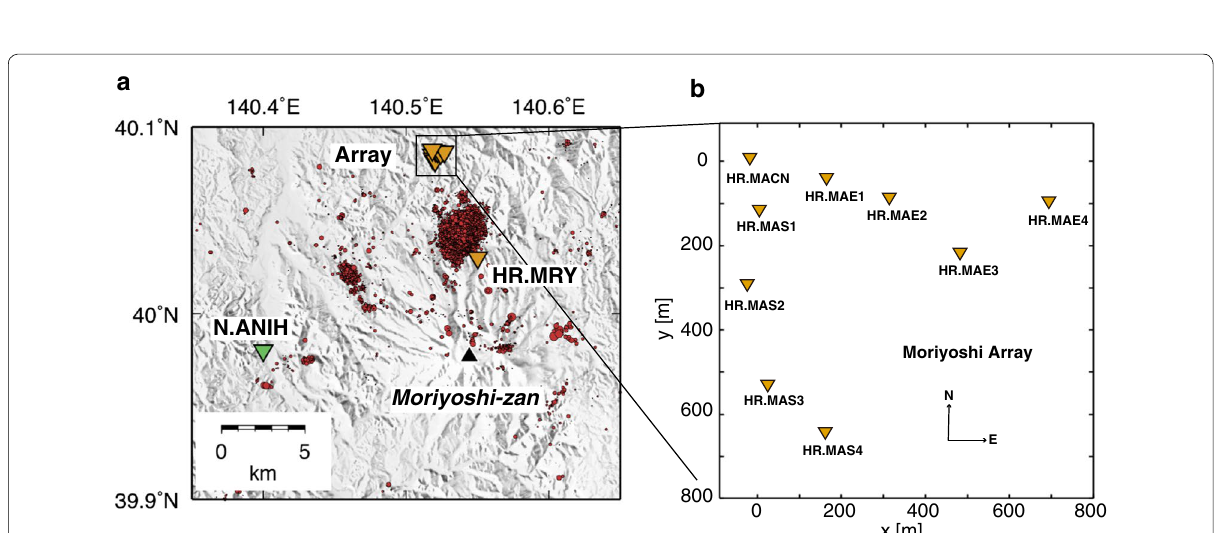
Fig. 7 a Location of the array. Green and orange inverted triangles represent Hi-net and temporary seismic stations, respectively. Red circles denote epicenters of earthquakes occurred during the period from March 2011 to November 2016. b Station distribution of the array. Orange inverted triangles represent the component stations of the